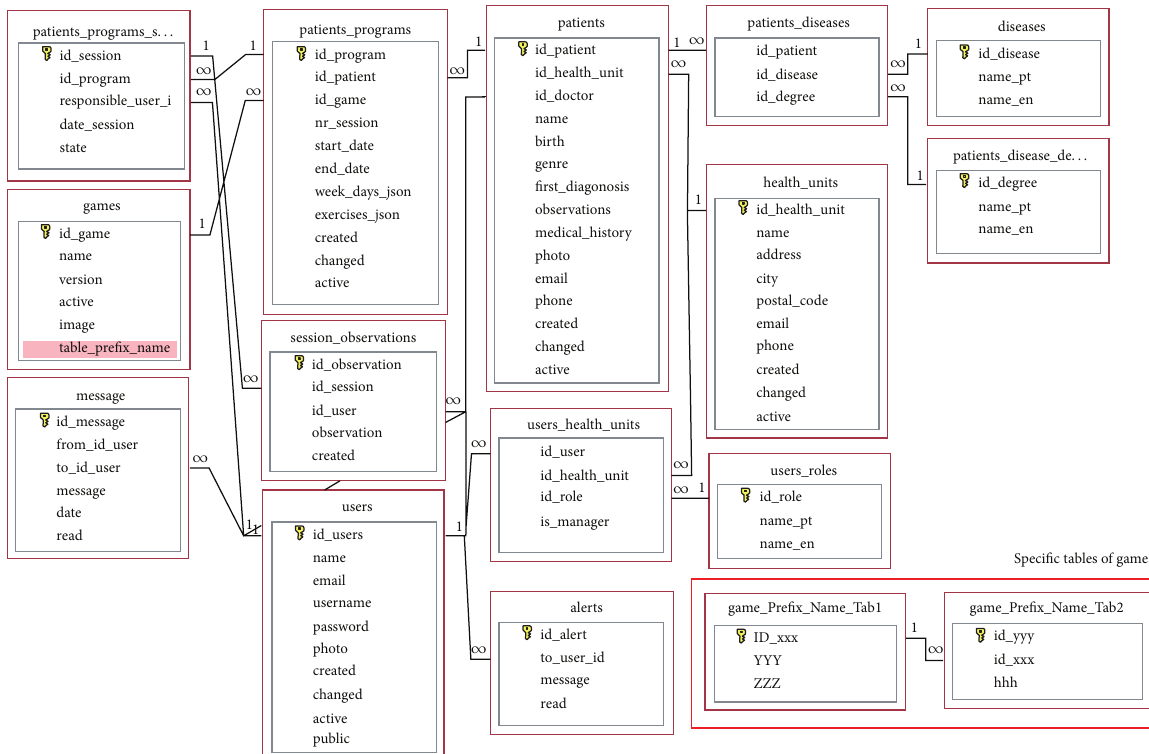
Figure 4: ER diagram of the Back Office